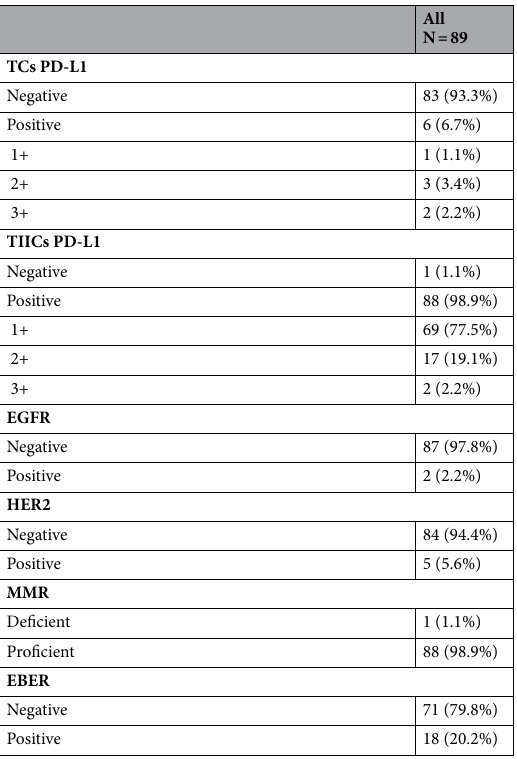
Table 2. Immunohistochemistry and in situ hybridisation. TCs tumour cells, TIICs tumour-infiltrating immune cells.